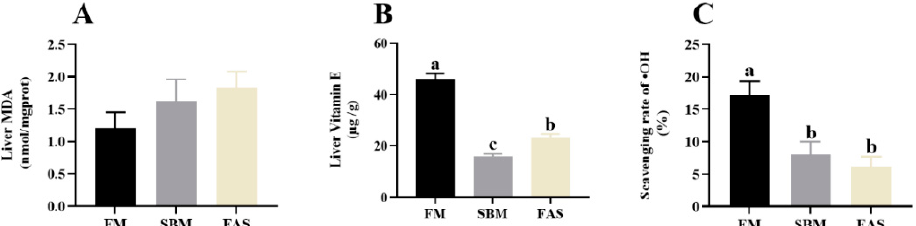
activity. Data are presented as means ± SEM. Bars sharing the same letters are not significantly dif-